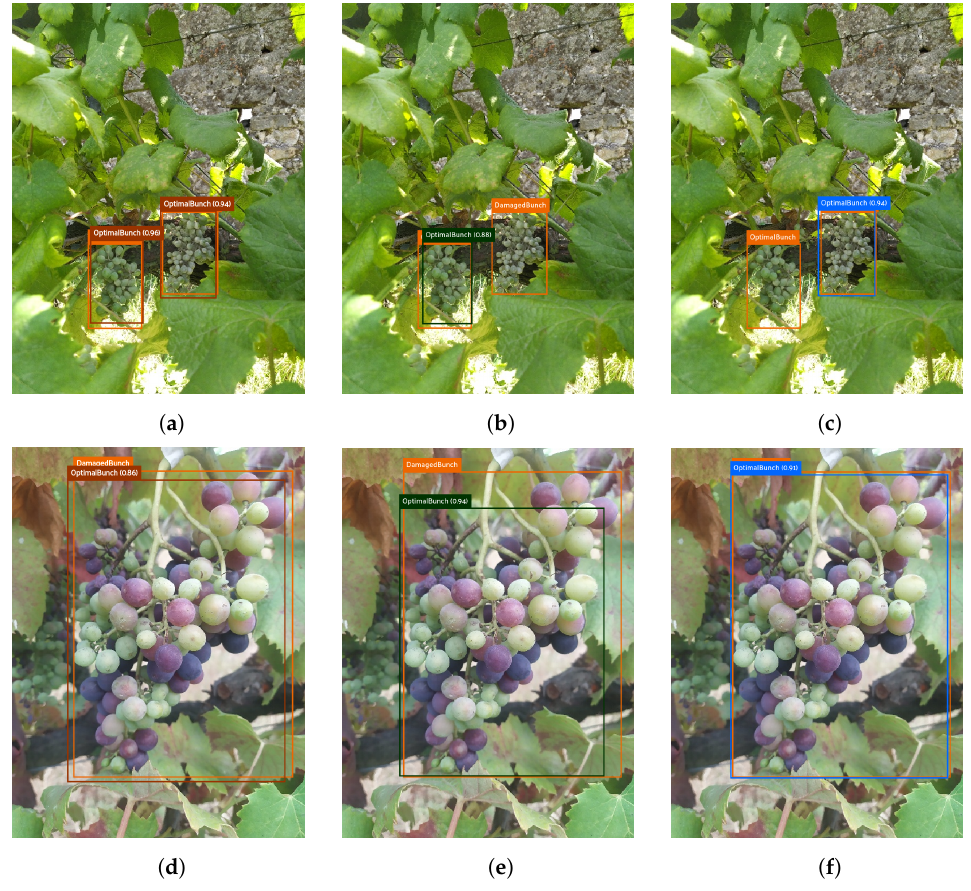
Figure 12. FNs on samples in the test set. Orange bounding boxes present ground truth. Red bounding boxes present the predictions from YOLOv5. Green bounding boxes present the predictions from YOLOv7. Blue bounding boxes present the predictions from YOLOR. ( a ) Example 1—YOLOv5. ( b ) Example 1—YOLOv7. ( c ) Example 1—YOLOR. ( d ) Example 2—YOLOv5. ( e ) Example 2—YOLOv7. ( f ) Example